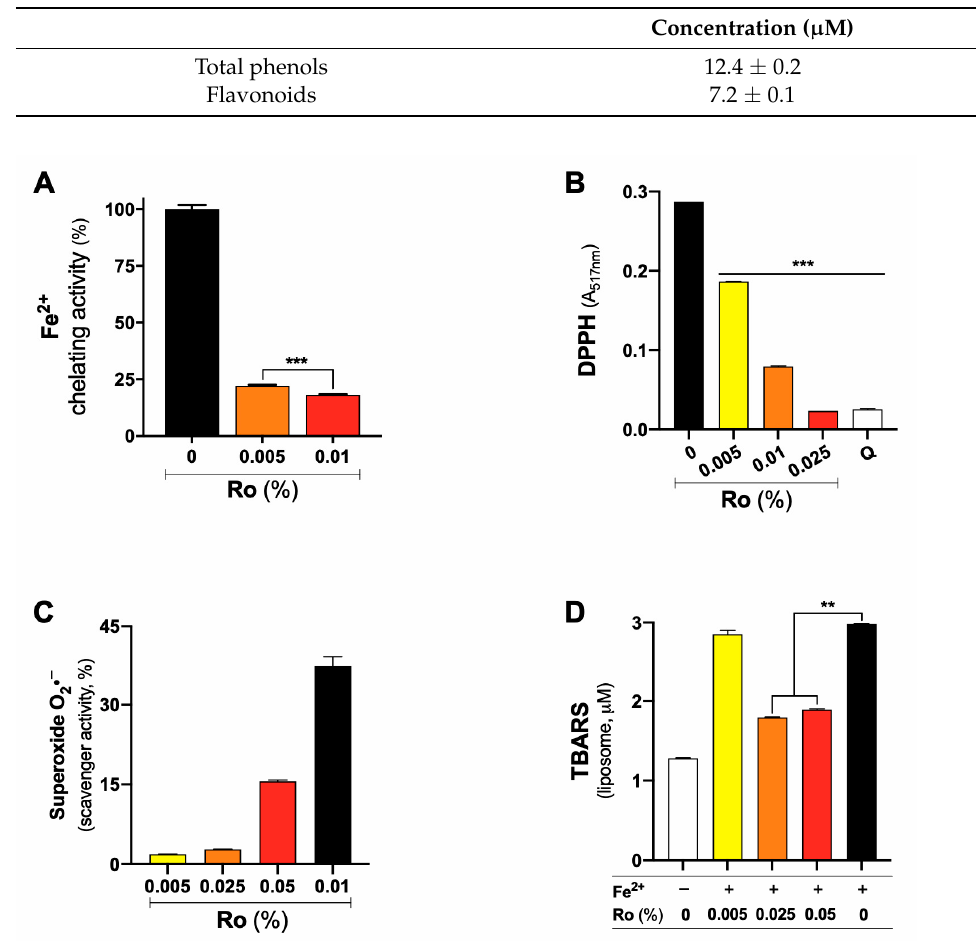
Figure 2. Fe 2+ chelating and free radical scavenger activities of glycolic extract of Rosmarinus officinalis ( Ro ). ( A ) 0.005 or 0.01% Ro were incubated with 50 μ M Fe(NH 4 ) 2 (SO 4 ) 2 and the absorbance